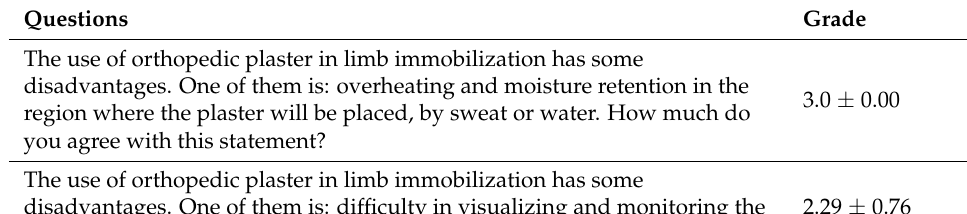
Table A1. Questions about orthopedic plaster with grades.